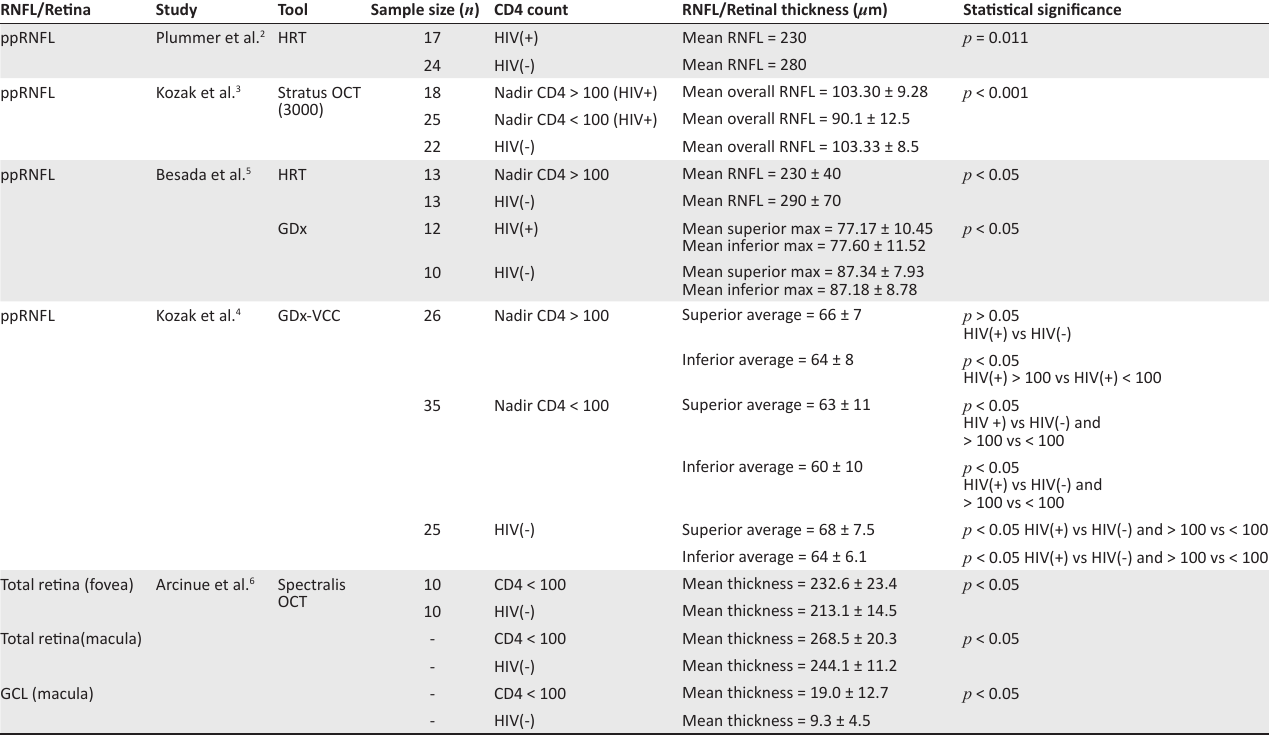
TABLE 1: Studies investigating retinal nerve fibre layer thickness in people living with HIV on antiretroviral therapy without retinitis.